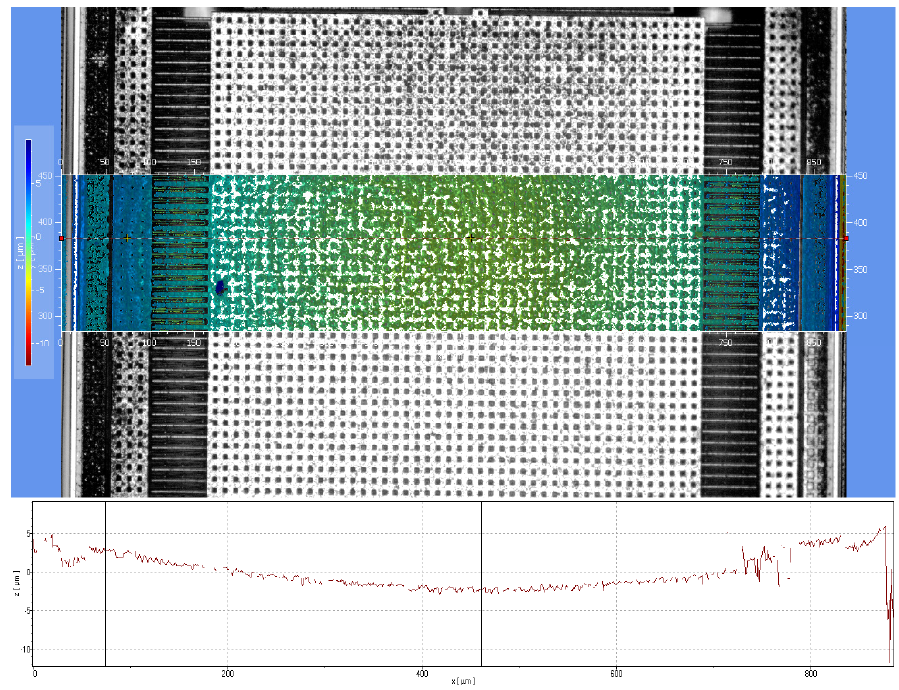
Figure 9. Cross section of the accelerometer.